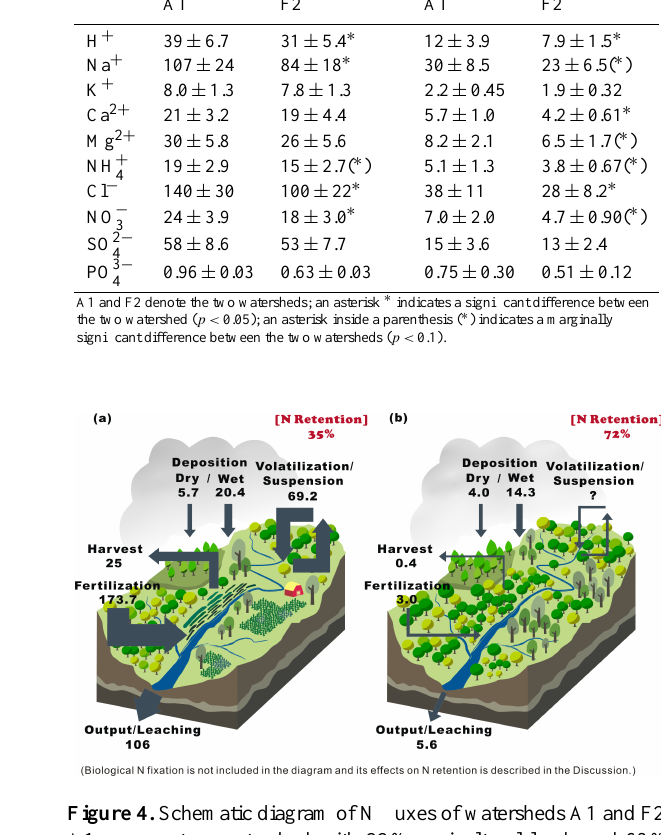
Figure 4. Schematic diagram of N fluxes of watersheds A1 and F2. A1 represents a watershed with 22% agricultural lands and 68% forests (a) ; F2 represents a watershed with 0.38% agricultural lands and 99% forests (b) (unit: kgNha − 1 yr − 1